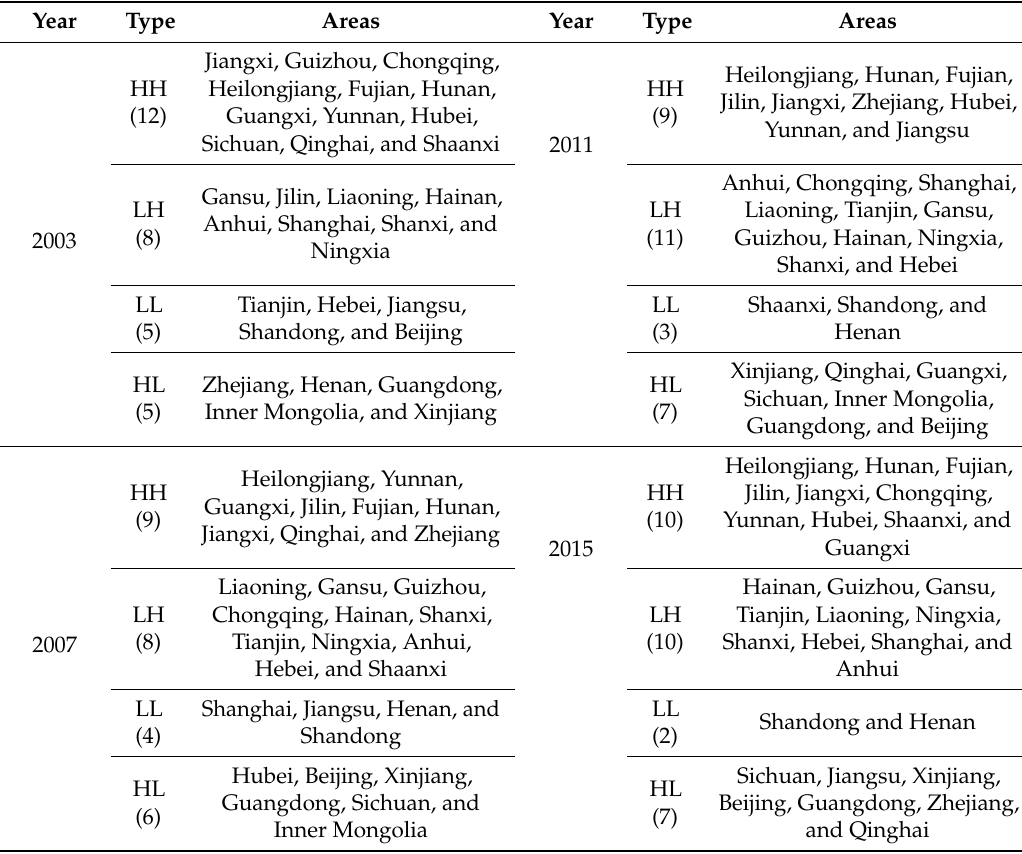
Table 4. Results of regional classification of land use eco-e ffi ciency of various provinces in China from 2003 to 2015 in selected years.